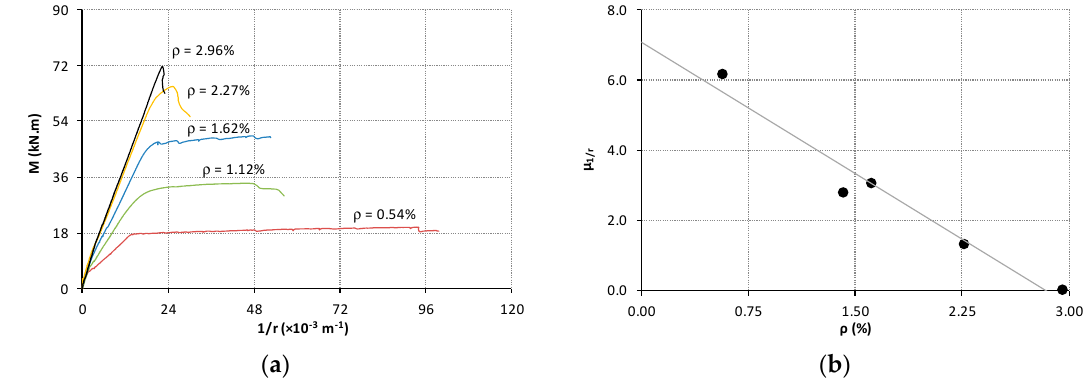
Figure 2. ( a ) Moment curvature relation, M-1/r; ( b ) Ductility index vs. tensile reinforcement ratio.